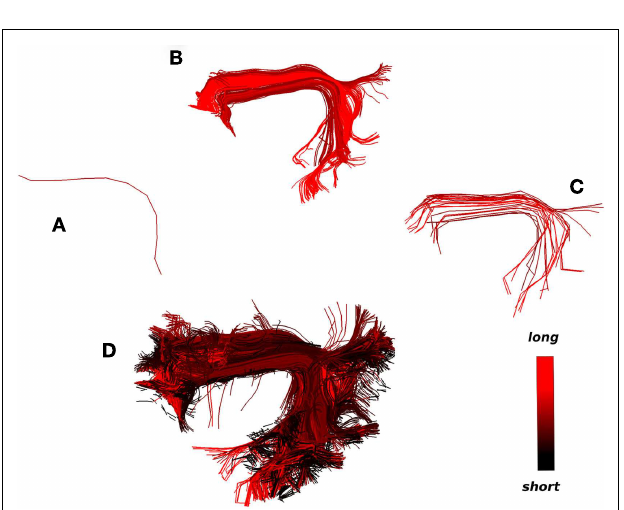
FIGURE 9 |What could be considered as the strength and limitation of QB is that short streamlines will be clustered differently from longer streamlines although they may belong in the same anatomical bundle. A solution to this problem is illustrated.The colormap here encodes streamline length. (A) A single centroid streamline, (B) the 245 actual streamlines closer than 15mm (MDF distance), (C) the streamlines from (B) clustered with 23 centroid streamlines using QB with threshold 6.25mm, (D) the 3421 actual streamlines closer than 6mm (MAM min distance) from the centroid streamlines in (C) are shown.We can see that a great number of short streamlines have been brought together along with the streamlines in (B)